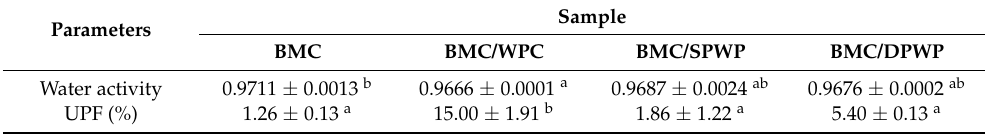
Table 4. Water activity and unbound protein fraction cheeses with polymerized whey